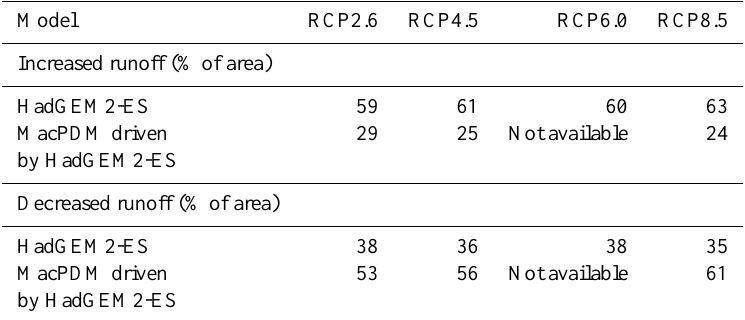
Table 3. Percentage of global land (excluding Antarctica) undergoing increased or decreased runoff by 2050 in HadGEM2-ES and MacPDM driven by HadGEM2-ES (Arnell and Lloyd-Hughes,